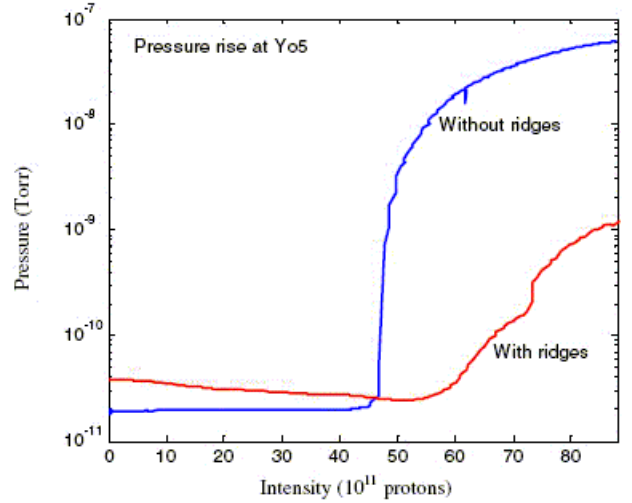
FIG. 23. (Color) Dynamic pressure in warm section YO5